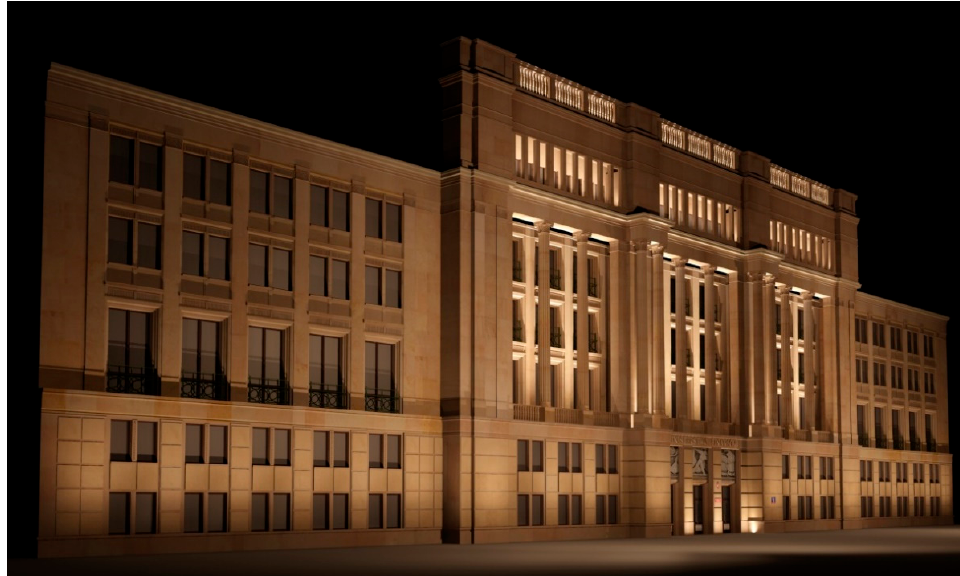
Figure 4. The final rendering of the object floodlighting concept.